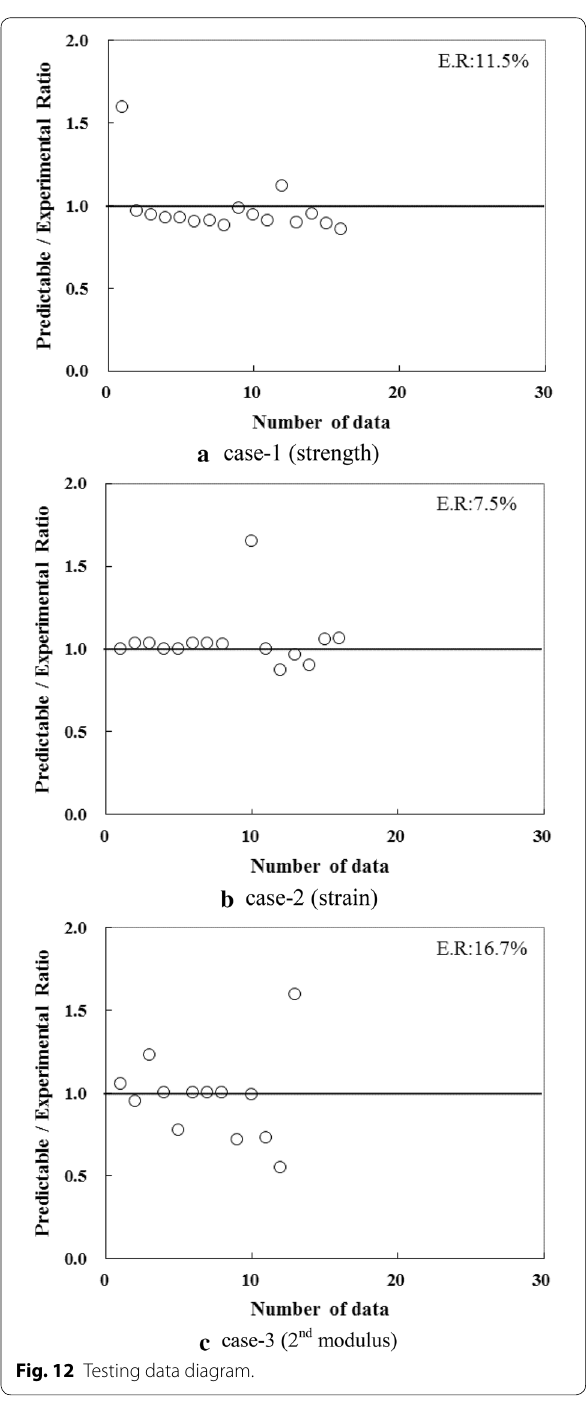
Fig. 12 Testing data